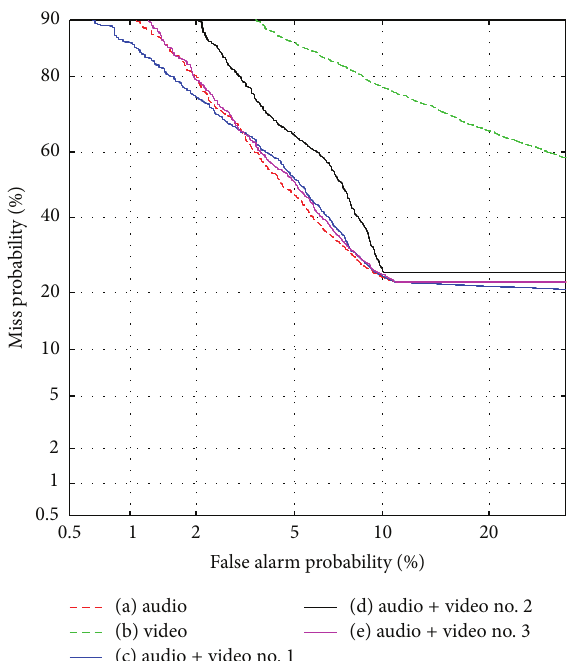
Figure 17: DET plot of voice activity detection performance for Dataset 2: solid lines—audio + video combinations, dashed lines— audio and video systems individually. VAD based on both audio and video modalities (audio + video no. 1) indicates better performance than audio-only